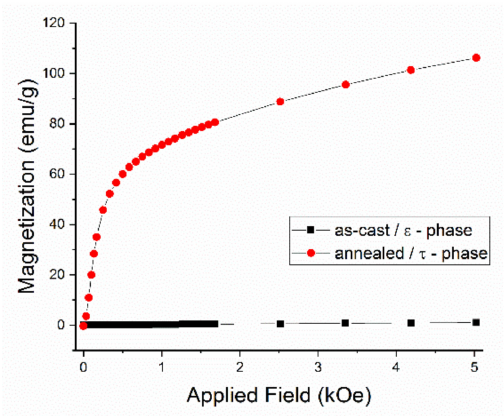
Figure 5. Initial magnetization for samples Mn 53 Al 45 C 2 as-cast and annealed at 700 ◦ C.